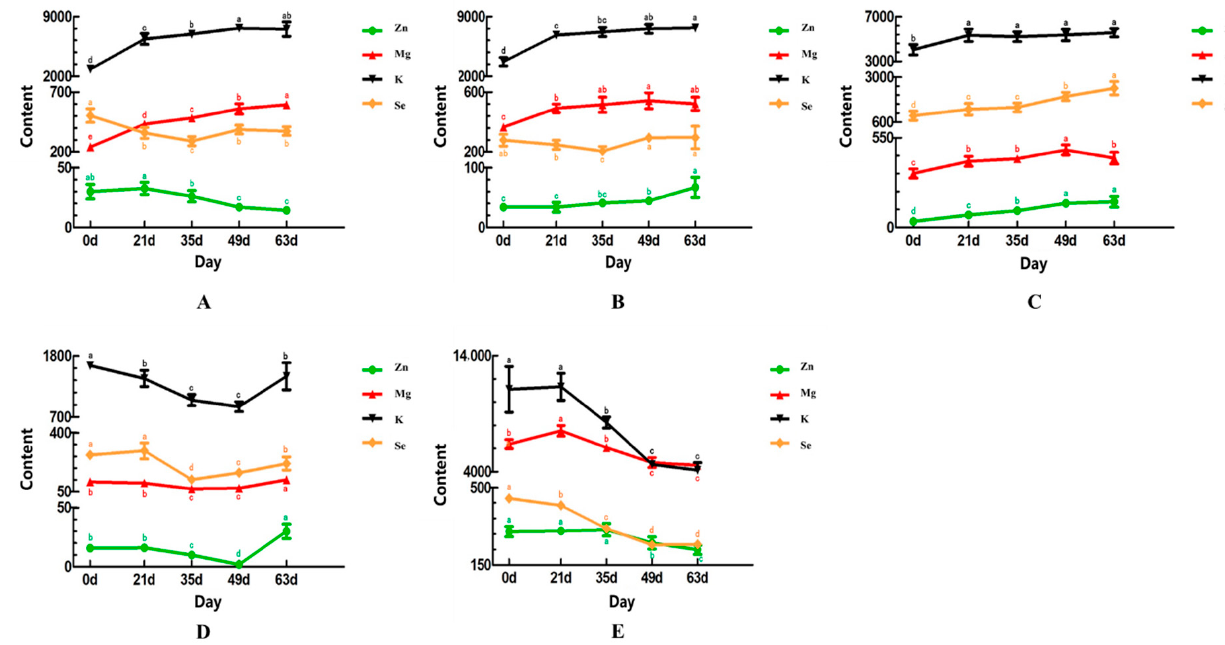
Figure 1. The dynamics of the mineral elements in the tissues at different ages. ( A ): breast muscle; ( B ): thigh muscle; ( C ): liver; ( D ): skin; ( E ): tibia. Note: different letters indicate significant differences ( p < 0.05), the same as below.